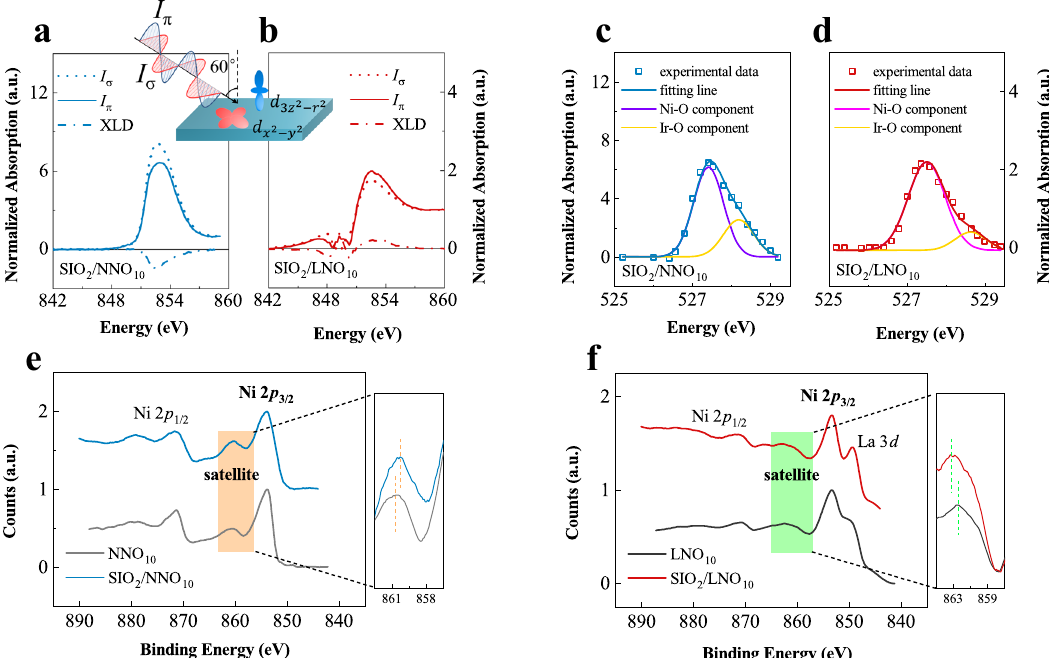
Fig. 3 Orbital polarization and pd hybridization. Ni L 3 -edge X-ray absorption spectra (XAS) measured with the incident beam linearly polarized in ( I σ ) or out ( I π ) of the fi lm plane and X-ray linear dichroism (XLD) spectra for a (SrIrO 3 ) 2 /(NdNiO 3 ) 10 bilayer, abbreviated as SIO 2 /NNO 10 ; and b (SrIrO 3 ) 2 / (LaNiO 3 ) 10 bilayer, abbreviated as SIO 2 /LNO 10 , where I σ , I π and XLD represents by dotted, solid and dashed lines, respectively. The inset is a sketch of the measurement geometry. c , d are the Gaussian fi tting of the O K pre-edge of SIO 2 /NNO 10 and SIO 2 /LNO 10 bilayers, respectively, where the purple and pink fi tting lines represent the contribution from the Ni – O pd hybridization, and the yellow fi tting line represents the contribution from the Ir-O pd hybridization, the blue and red open squares and lines represent the experimental data and cumulative fi tting lines. e , f Ni 2 p X-ray photoelectron spectra (XPS) of the SIO 2 /NNO 10 bilayer (blue line) in comparison with the NNO 10 thin fi lm (gray line), and the SIO 2 /LNO 10 bilayer (red line) in comparison with the LNO 10 thin fi lm (black line), respectively. The XPS of the bilayer is shifted to make the binding energy of Ni 2 p fi lm and bilayer as the same. The shaded 3/2 of the thin Ni 2 p 3/2 satellite peaks are rescaled in the right panel to emphasize the shift of peak position, which are indicated by the orange and green dashed components 35 . In Fig. 3c, d, the peak at 528.2 eV and 528.6 eV can be assigned to the Ir-O contribution 36 , while the peaks at 527.4 eV and 527.5 eV are from the Ni-O contribution 37 . The are shown in Supplementary Fig. 4. The FWHM value of the Ni- O components in the O K pre-edge peak of SIO 2 /NNO 10 , NNO 10 , SIO 2 /LNO 10 and LNO 10 is 0.90, 0.98, 1.12 and 1.00 eV, respectively. The smaller FWHM in SIO 2 /NNO 10 and the larger